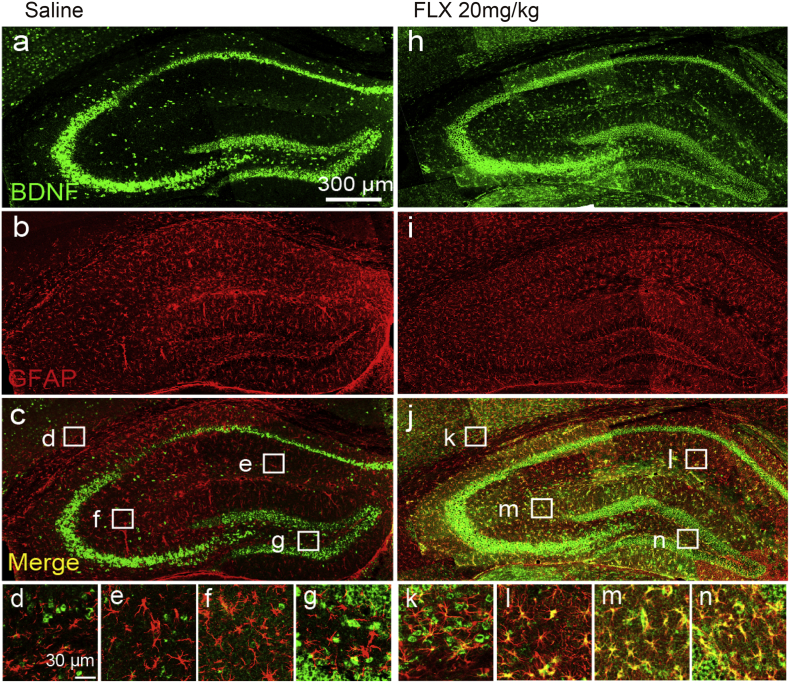
Chronic administration of FLX upregulates BDNF in hippocampal astrocytes.Double immunostaining of hippocampal sections with anti-BDNF (green) and anti-GFAP (red) antibodies. a-c are images of saline administered mice. h-j are FLX (20 mg/kg for 21 days, p.o.) administered mice. d-g and k-n are the magnified insets shown in c and j, respectively. Scale bars: a, 300 μM; d, 30 μM. These are representative of at least 3 independent experiments where similar results were obtained.